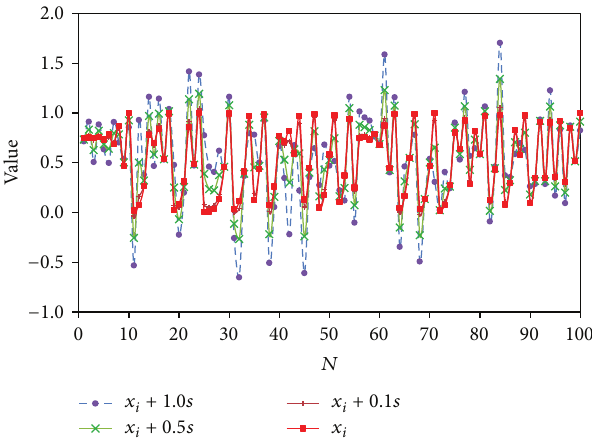
Figure 1: Logistic series with the noise levels of 10%, 50%, and 100% ( 𝑁 = 1 ∼